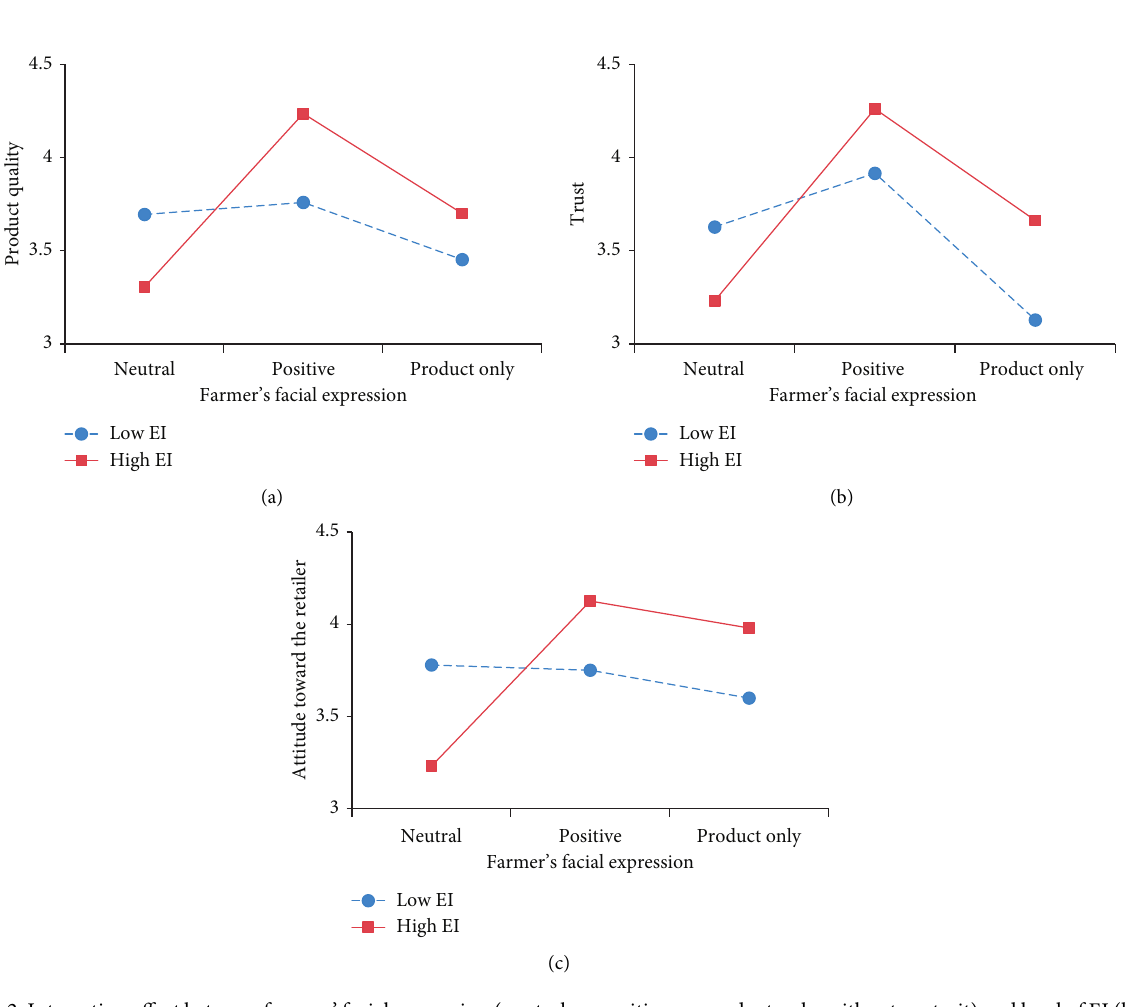
Figure 2: Interaction effect between farmers’ facial expression (neutral vs. positive vs. product only, without portrait) and level of EI (low vs. high) in consumers’ responses, (a) perceived product quality, (b) trust toward the local food retailer, and (c) attitude toward the local food